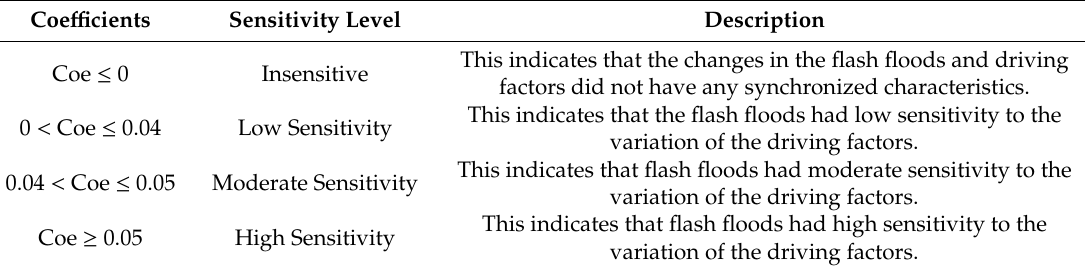
Table 4. Coe ffi cients (Coe) corresponding to the sensitivity